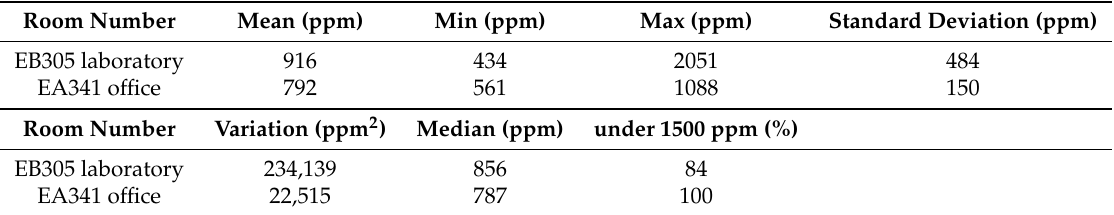
Table 3. Summary of statistical information of the data collected on 18 of February 2019 at the Department of Cybernetics and Biomedical Engineering,